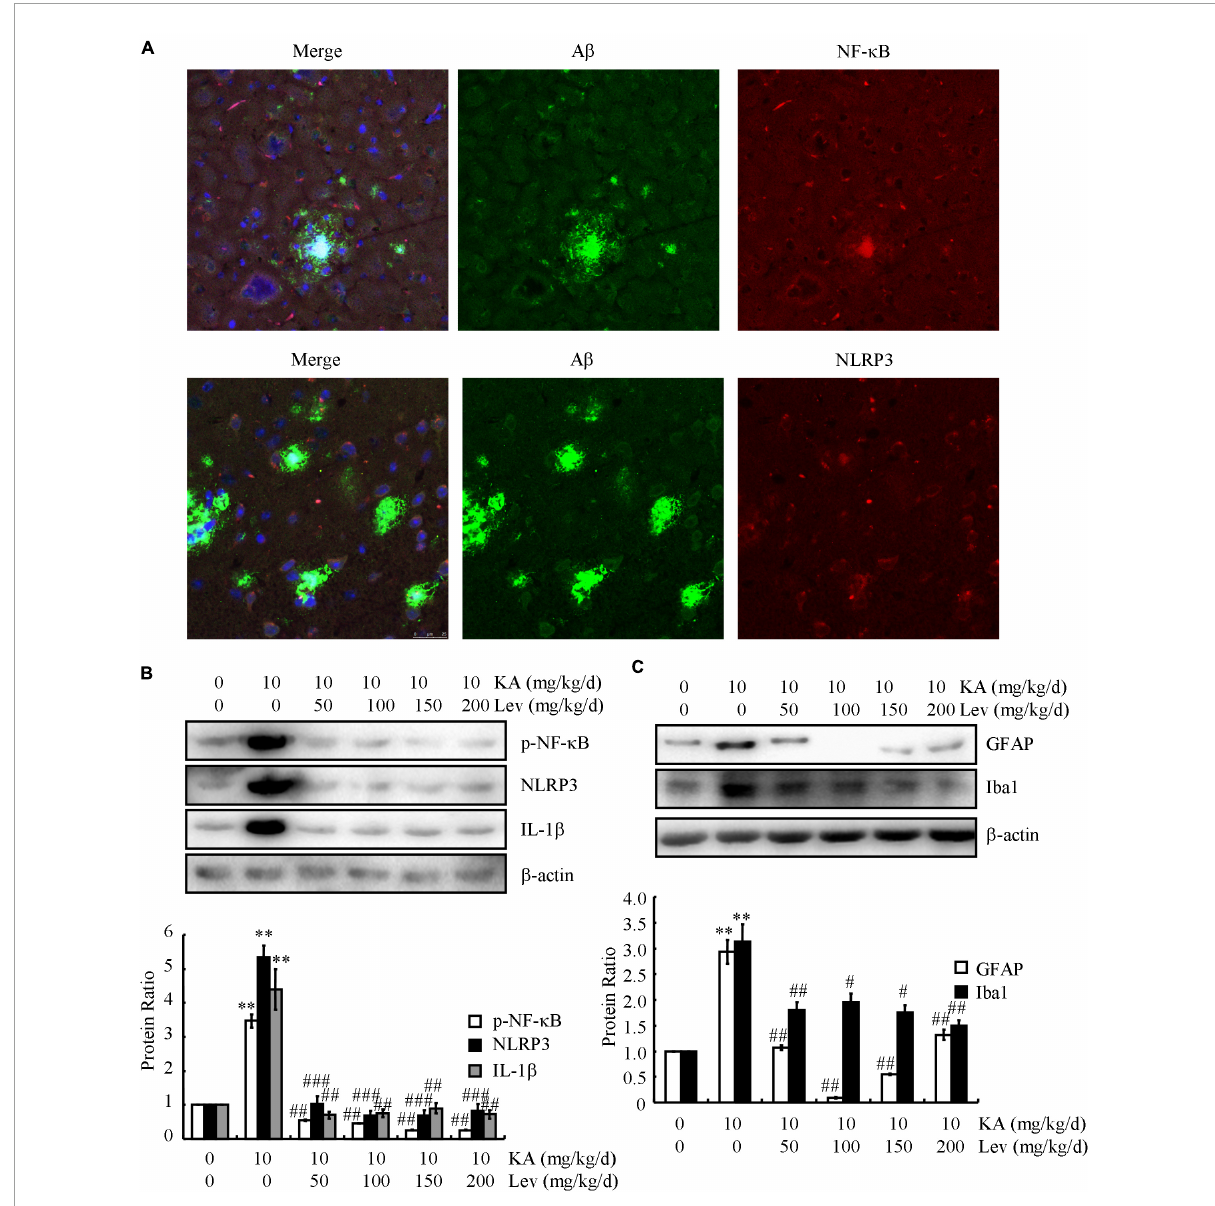
FIGURE5 LEV treatment mitigates the effects of KA on activating inflammasomes in the brains of APP23/MAPT mice. (A) Images from a single z-plane of the brains of 9-month-old APP23/MAPT mice using monoclonal antibodies against A β (green), NF- κ B/NLRP3 (red), and the nucleus (blue DAPI stain). (B,C) The phosphorylation level of NF- κ B and the total protein levels of NLRP3, IL-1 β , GFAP, and Iba1 in the brains of KA- or LEV (50, 100, 150, or 200 mg/kg) + KA-treated APP23/MAPT mice, as determined by western blots. The optical densities of bands in the western blots